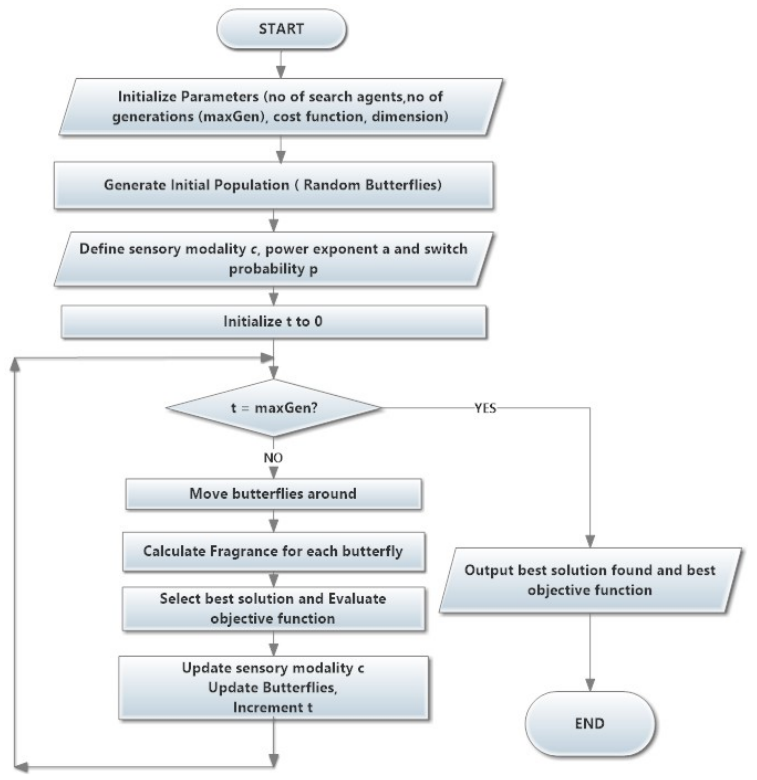
Figure 3. BO Algorithm